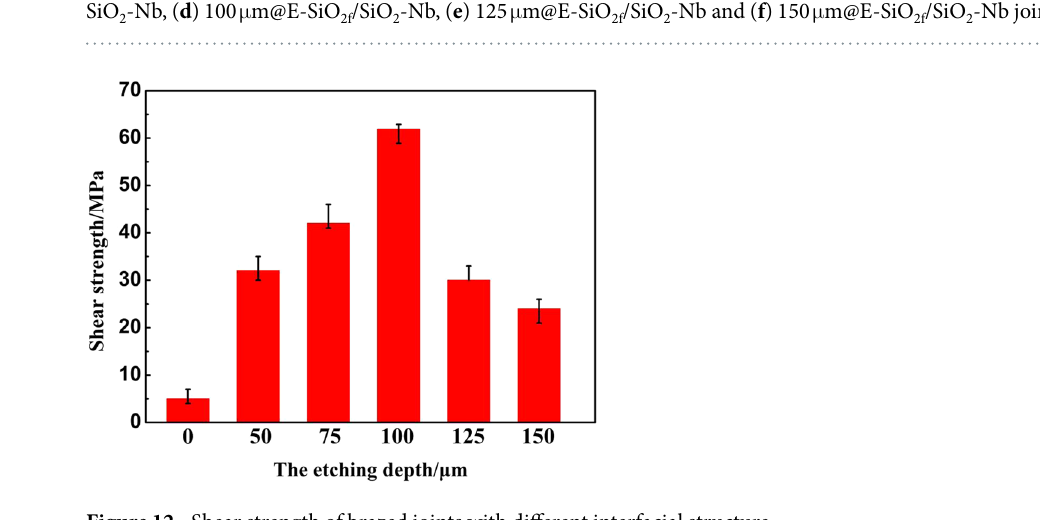
Figure 12. Shear strength of brazed joints with different interfacial